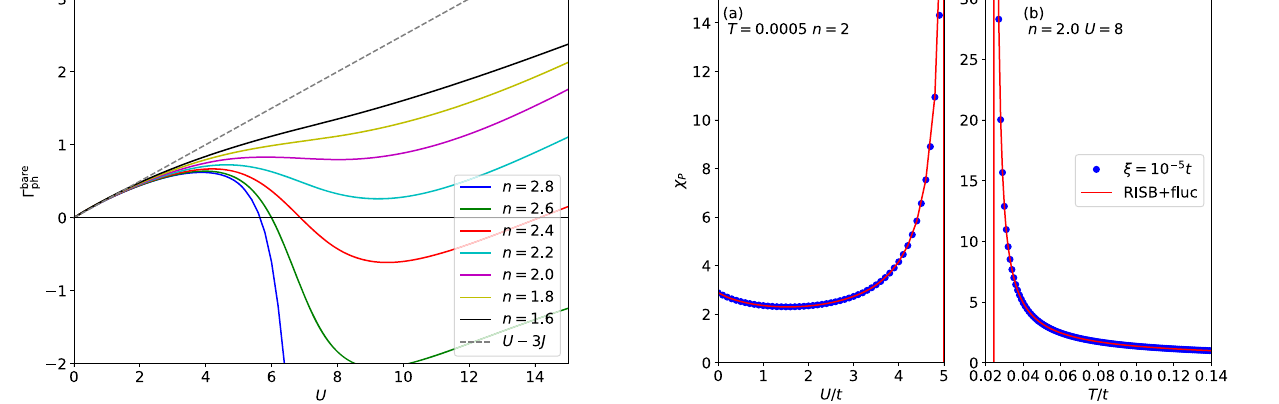
FIG. 11. Comparison of the uniform pairing susceptibility χ P ð q ¼ 0 ; ω ¼ 0 Þ evaluated from the fluctuation approach with the pairing susceptibility evaluated from the mean-field solution χ P ¼ ð d h O =d ζ Þ with small pairing field ζ ¼ 10 − 5 for (a) tem- P i perature T ¼ 0 . 0005 t and filling n ¼ 2 . 0 and (b) Coulomb interaction U ¼ 8 t and filling n ¼ 2 . 0 . We fix Hund ’ s coupling interaction at J ¼ U= 4 .